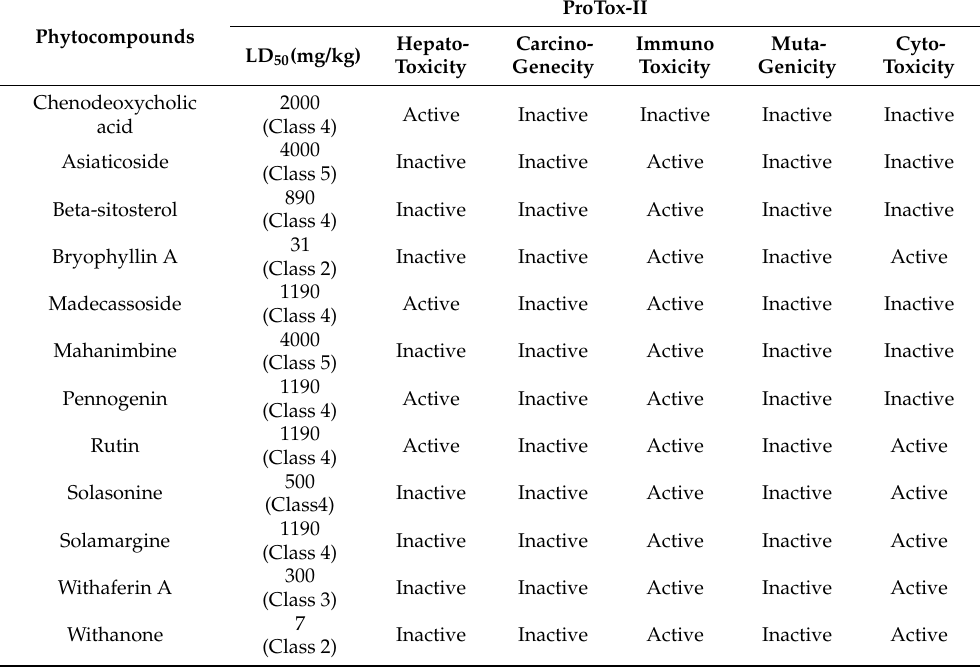
Table 4. Toxicity prediction of active phytocompounds and bile